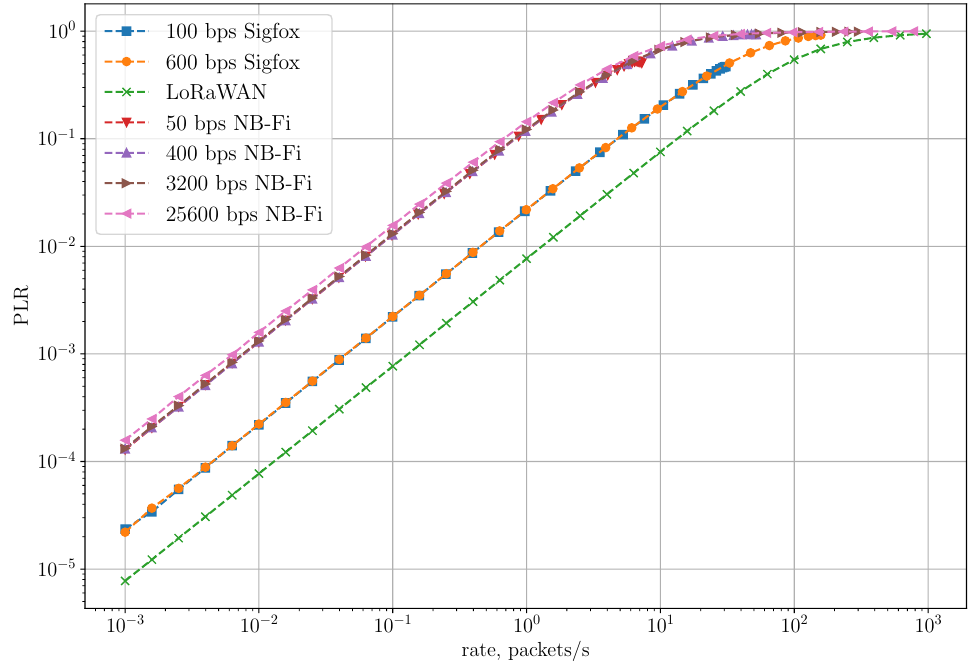
Figure 11. PLR for the unreliable transmission of long packets